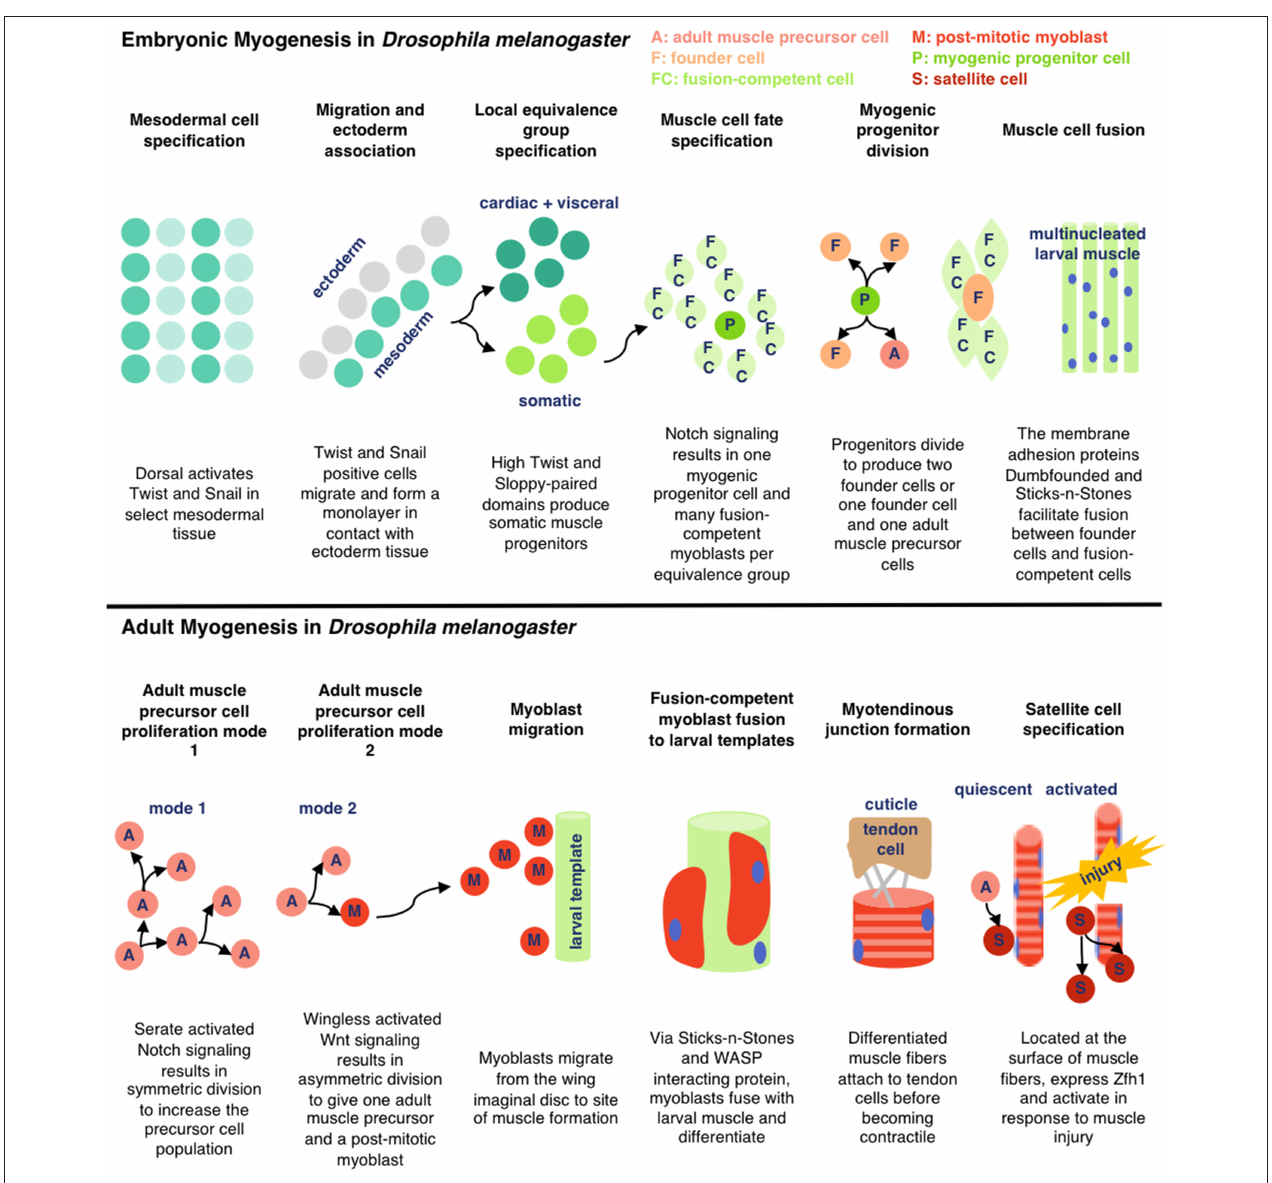
FIGURE 2 | Simplified schematic of embryonic and adult muscle development in D. melanogaster as detailed in Gunage et al. (2017) (License: CC BY 4.0). The adult muscle development is specific for dorsal longitudinal indirect flight